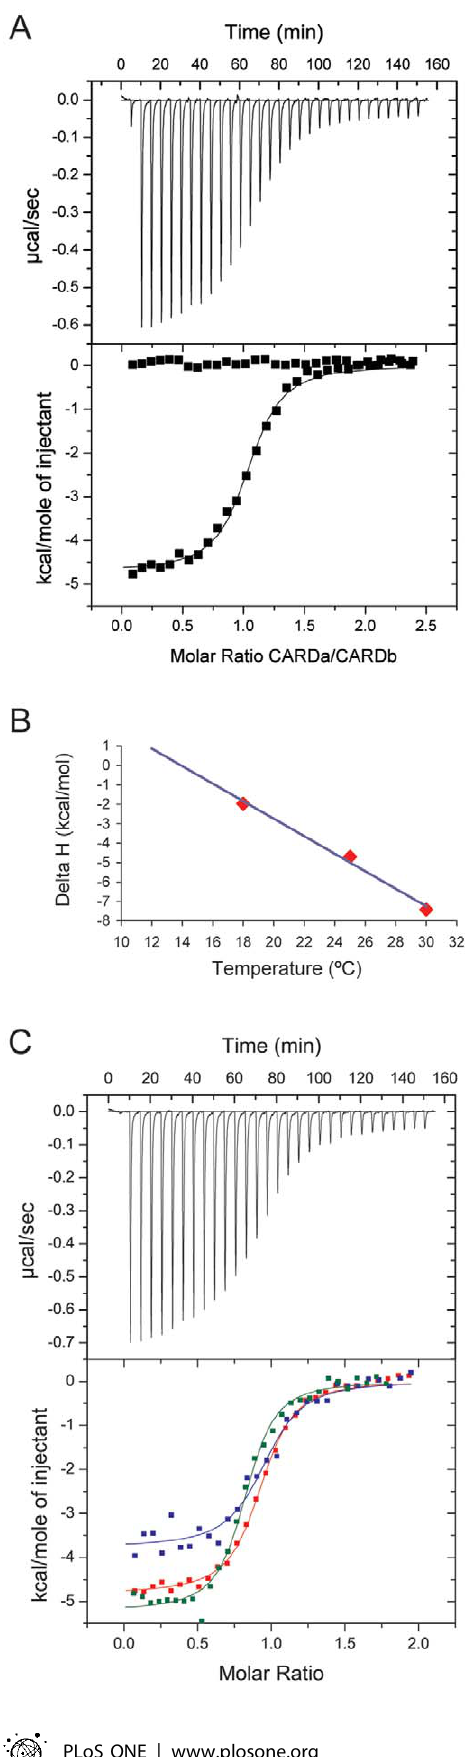
Figure 3. Thermodynamics of the NOD2 CARDa-CARDb interaction. (A) ITC measurement of complex formation between CARDa in the syringe (475 m M) and CARDb in the cell (45 m M). T=25 u C. The binding isotherm was fitted to a one-site binding model with a K d of 1.1 m M. A control experiment of CARDa into buffer is shown. (B) Determination of the heat capacity, D C p . Enthalpies, D H, from CARDa- CARDb titrations at different temperatures were plotted against the temperatures. Linear regression analysis gave D C p = d D H/ dT= 2 450 cal/(mole u C). (C) Effect of CARDa point mutations as monitored by ITC at 25 u C. Titration of CARDa E69K (345 m M) into